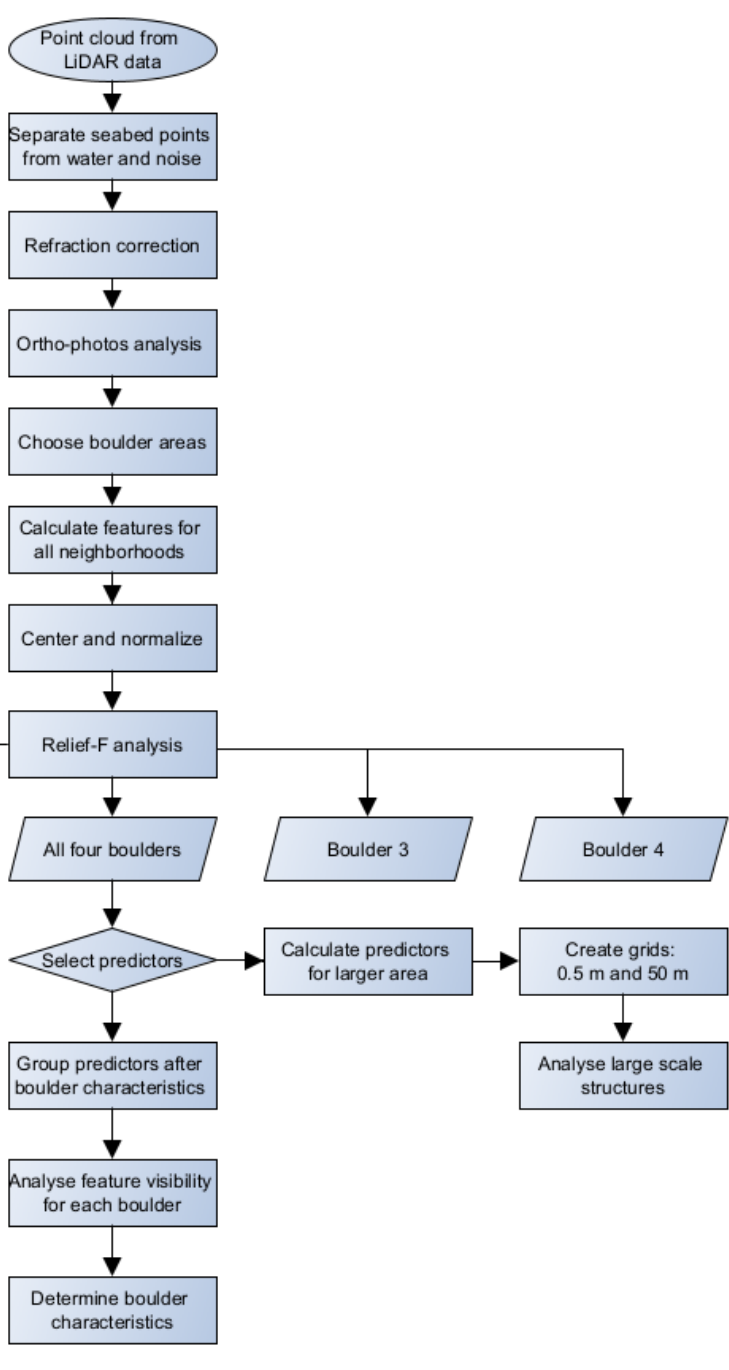
Figure 2. Workflow diagram describing the processing steps in the